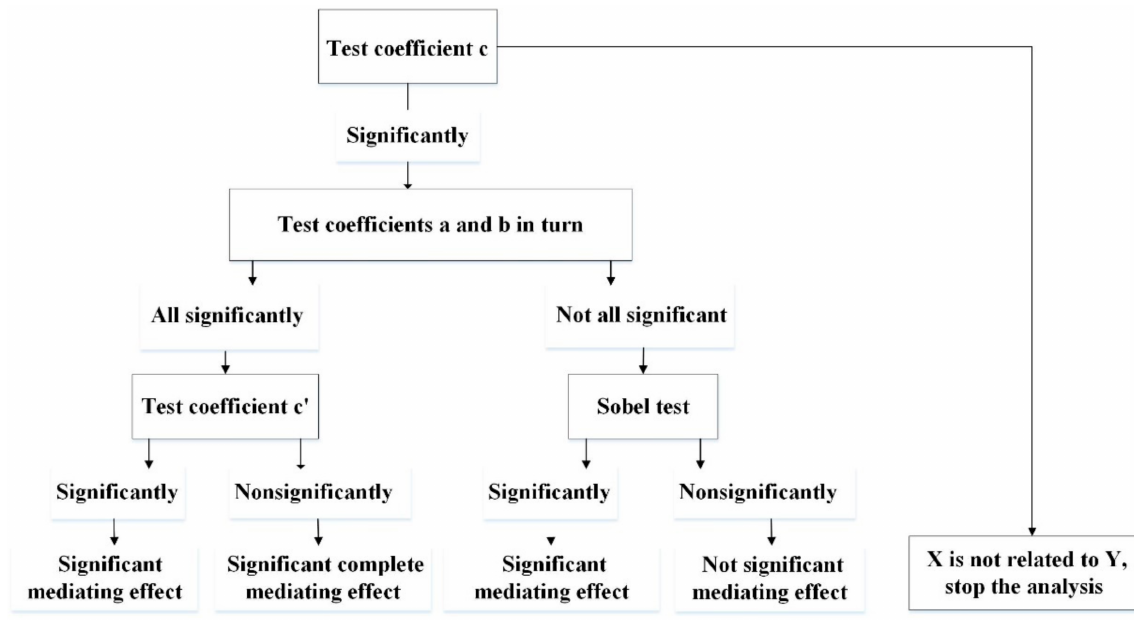
Figure 3. Mediating effect test